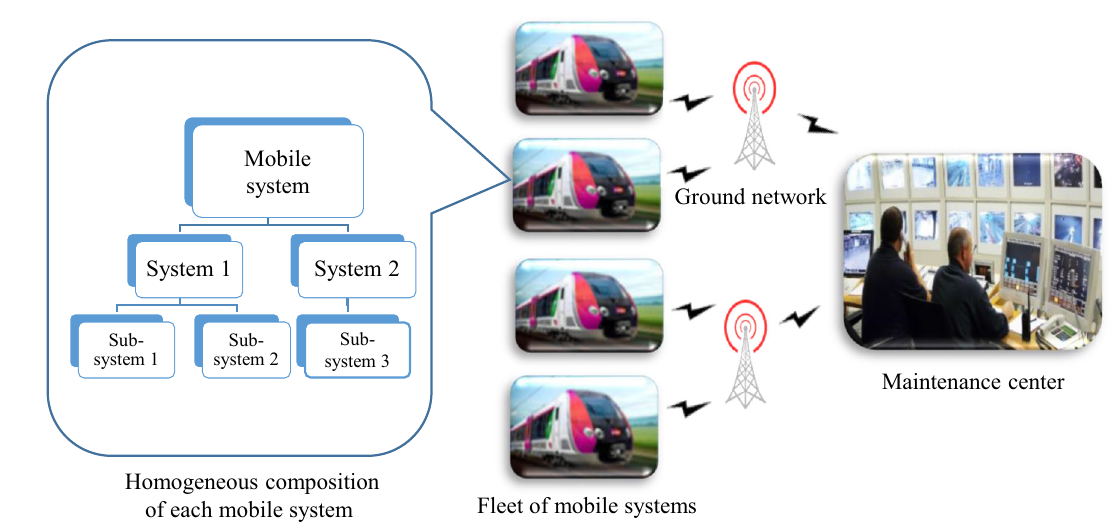
Fig. 1 Fleet of mobile systems monitored and maintained by a maintenance